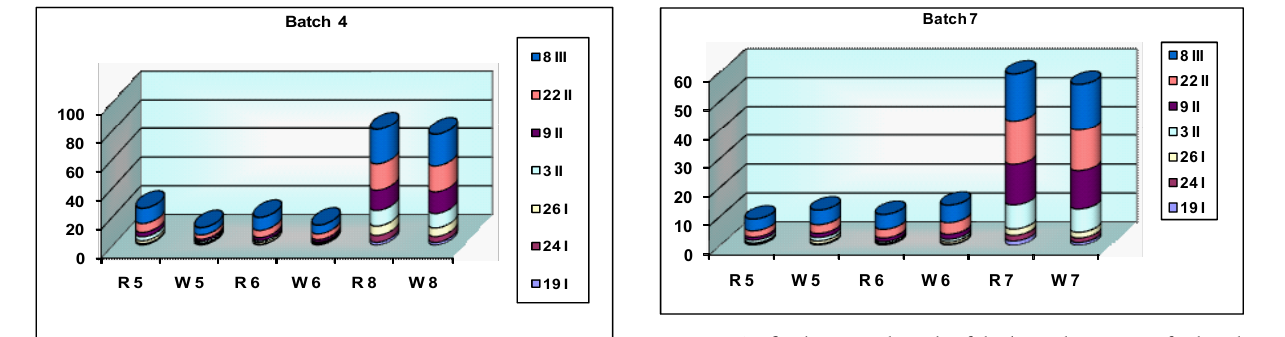
Fig. 11. The final average length of the branches, in cm, for